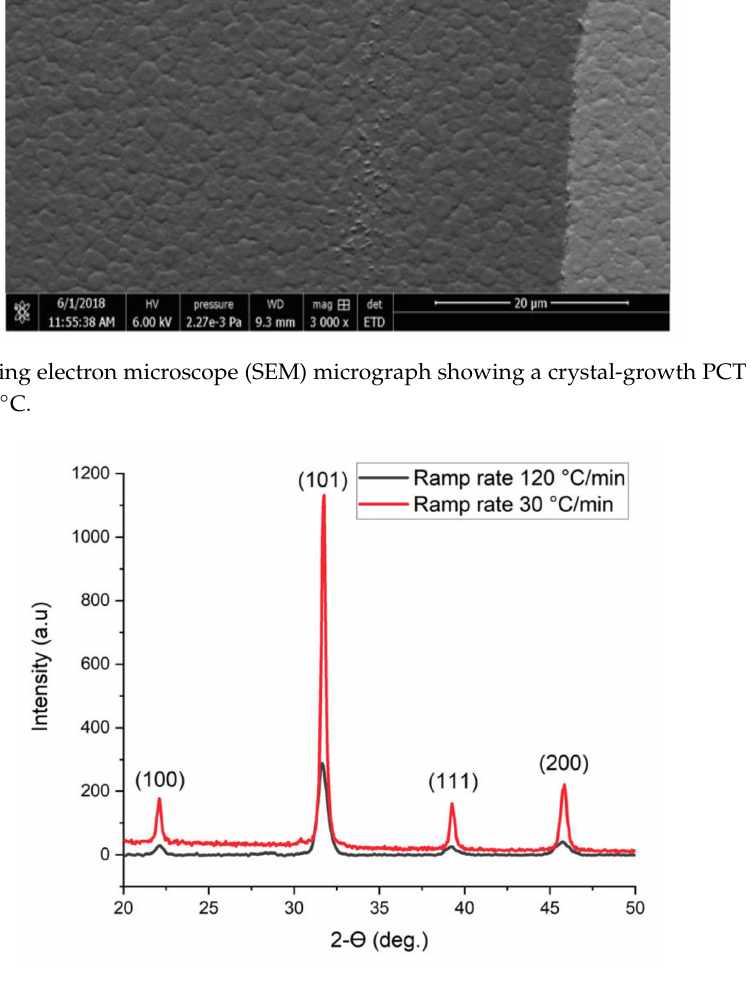
Figure 4. X-ray di ff raction data for PCT thin films deposited at 550 ◦ C and annealed at 550 ◦ C for 15 min on silicon: temperature ramping rate 120 ◦ C / min (black) and temperature ramping rate 30 ◦ C / min